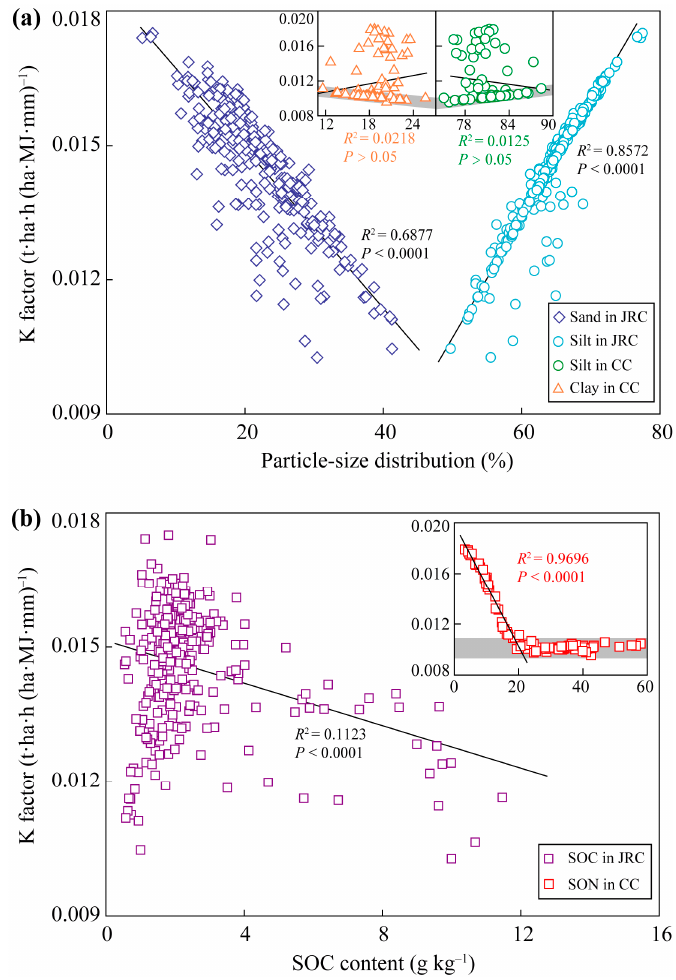
Figure 6. Relationships between K factor and the soil properties in the soils of the JRC and CC by line regression analysis. ( a ) Relationships between K factor and soil particle size distribution; ( b ) relationships between K factor and SOC content. The three small-sized graphs of CC were cited from an unpublished paper, the points located in the shadow area were mainly surface soil samples.